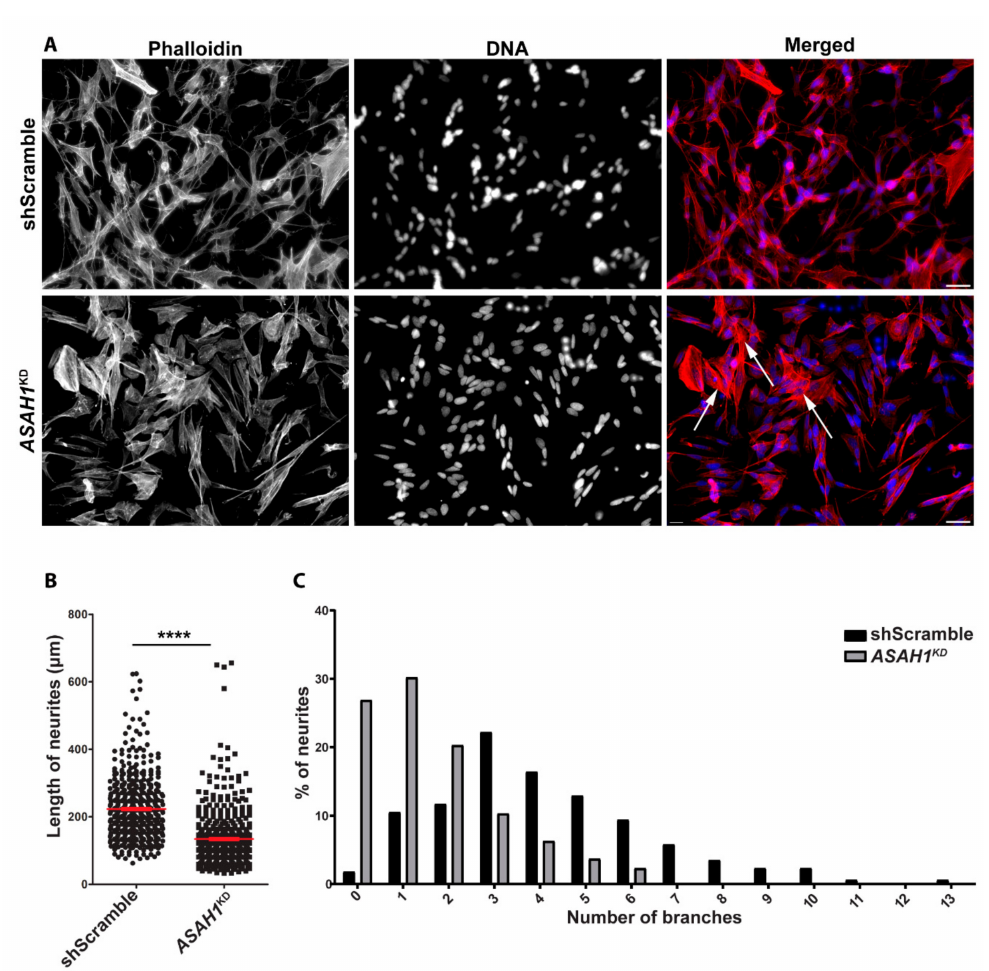
Figure 7. ASAH1 KD cells display short neurites and fewer branches per neurite. ( A ) Immunofluorescence microscopy images of di ff erentiated shScramble and ASAH1 KD cells stained with the phalloidin (Alexa Fluor ® 568 dye, red). Nuclei were stained with Hoechst dye (blue). The scale bars correspond to 40 µ m. White arrows show cells with stress fibers. ( B ) Length of neurites ( µ m) per cell. The mean neurite length was significantly lower in ASAH1 KD cells compared to shScramble cells (**** p < 0.0001, Student t -test). ( C ) Distribution of the number of branches per neurite ( p < 0.0001, Chi-square